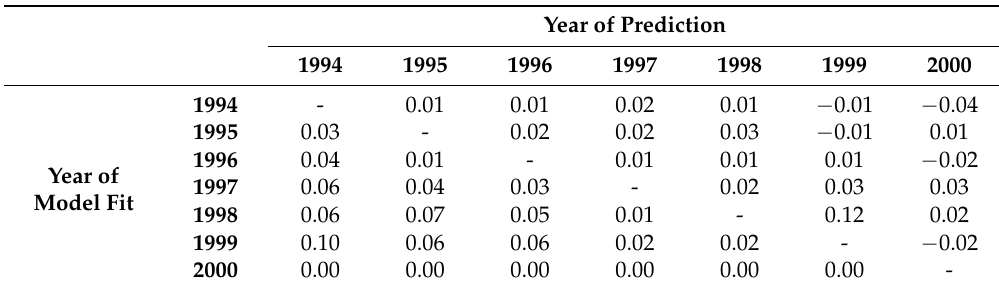
Table 5. Difference between AUC values corresponding to the full model set (with both Wetness and Brightness slopes) and the plain model set (with no remote sensing